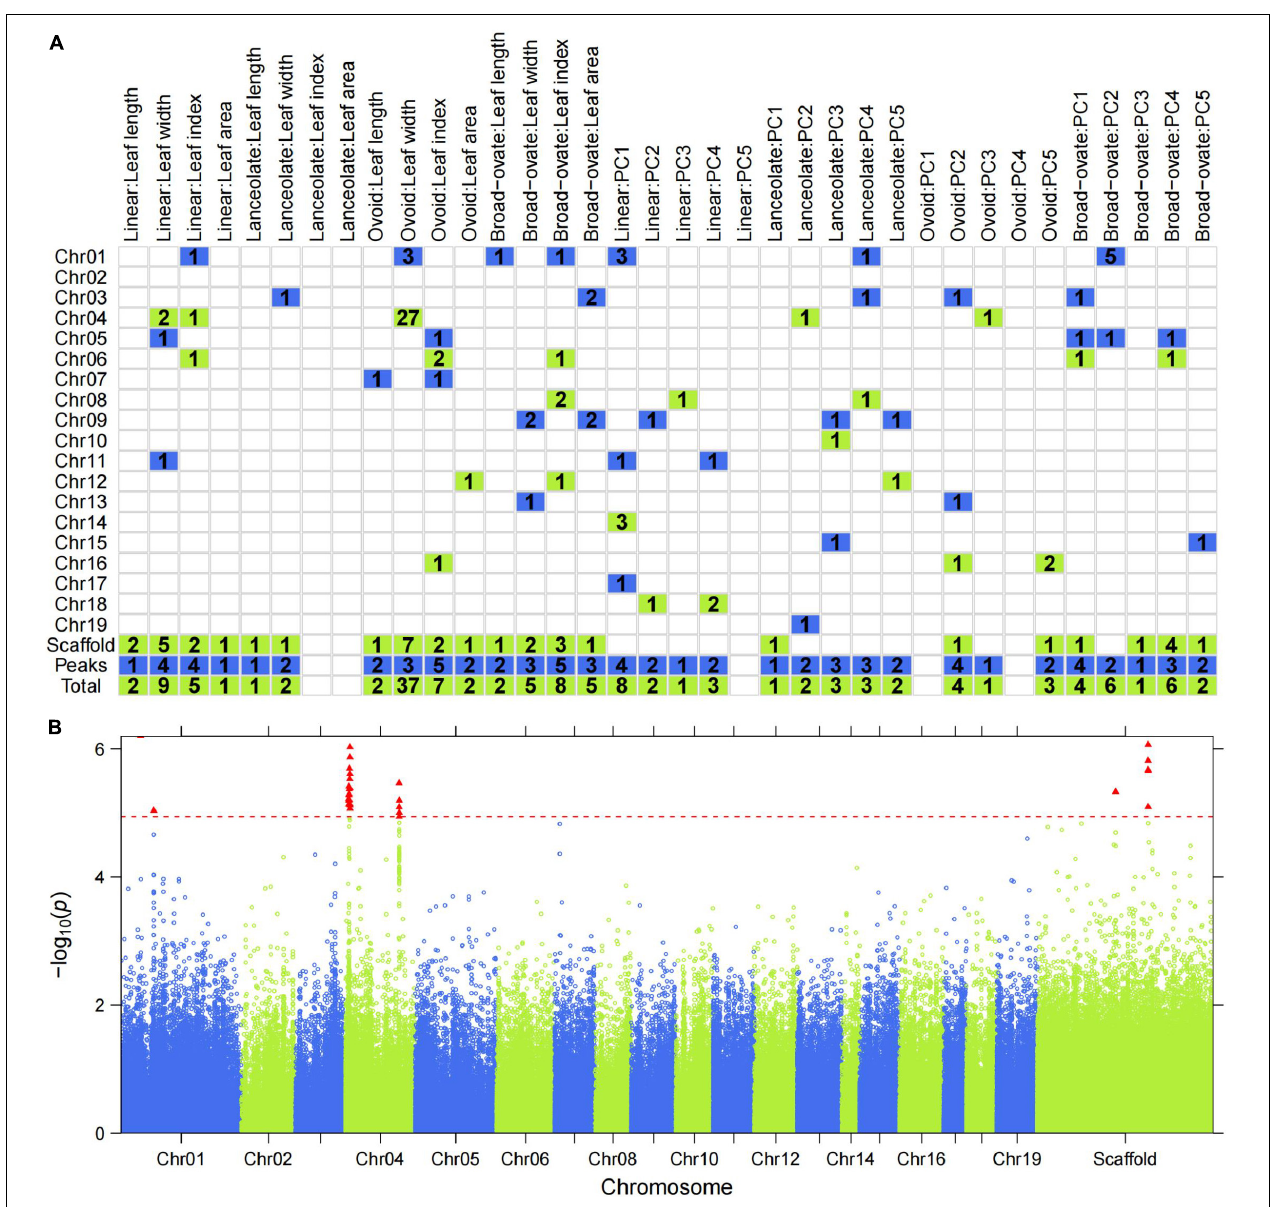
FIGURE 4 | Genome-wide distribution of P. euphratica SNP loci detected based on single-leaf GWAS. (A) Distribution of the number of significant SNPs across each chromosome for all traits. (B) Manhattan plot displaying the GWAS result of the trait ‘Ovoid: Length width’ based on the LM model. The red triangle indicates the significantly associated SNPs. Redline indicates the threshold with permutation tests at